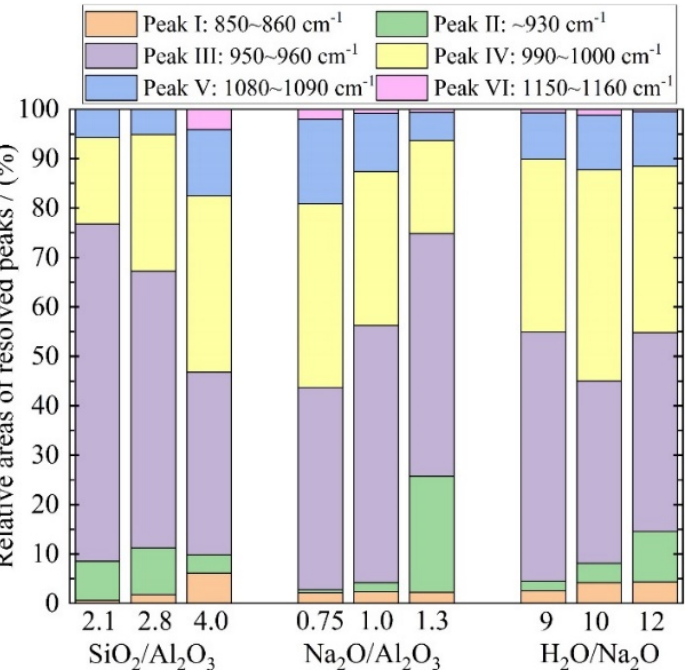
Figure 8. Relative areas of the deconvoluted component peaks within the main Si-O-T